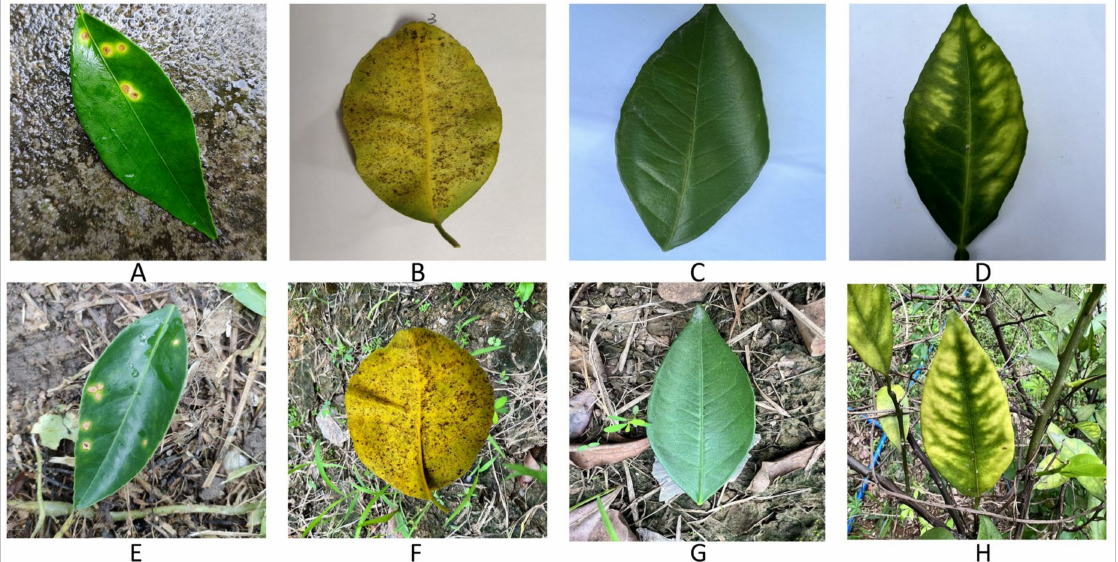
Figure 1. The four kinds of leaves used in the experiment: ( A , E ) canker, ( B , F ) melanose, ( C , G ) healthy, ( D ) magnesium deficiency, and ( H ) zinc deficiency; ( A – D ) is simple background, ( E – H ) is compli- cated background.